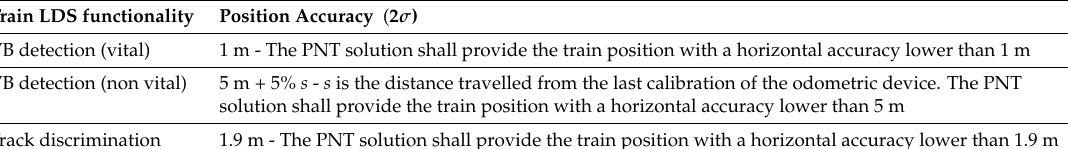
Table 4. PNT (including GNSS) Integrity requirements for rail